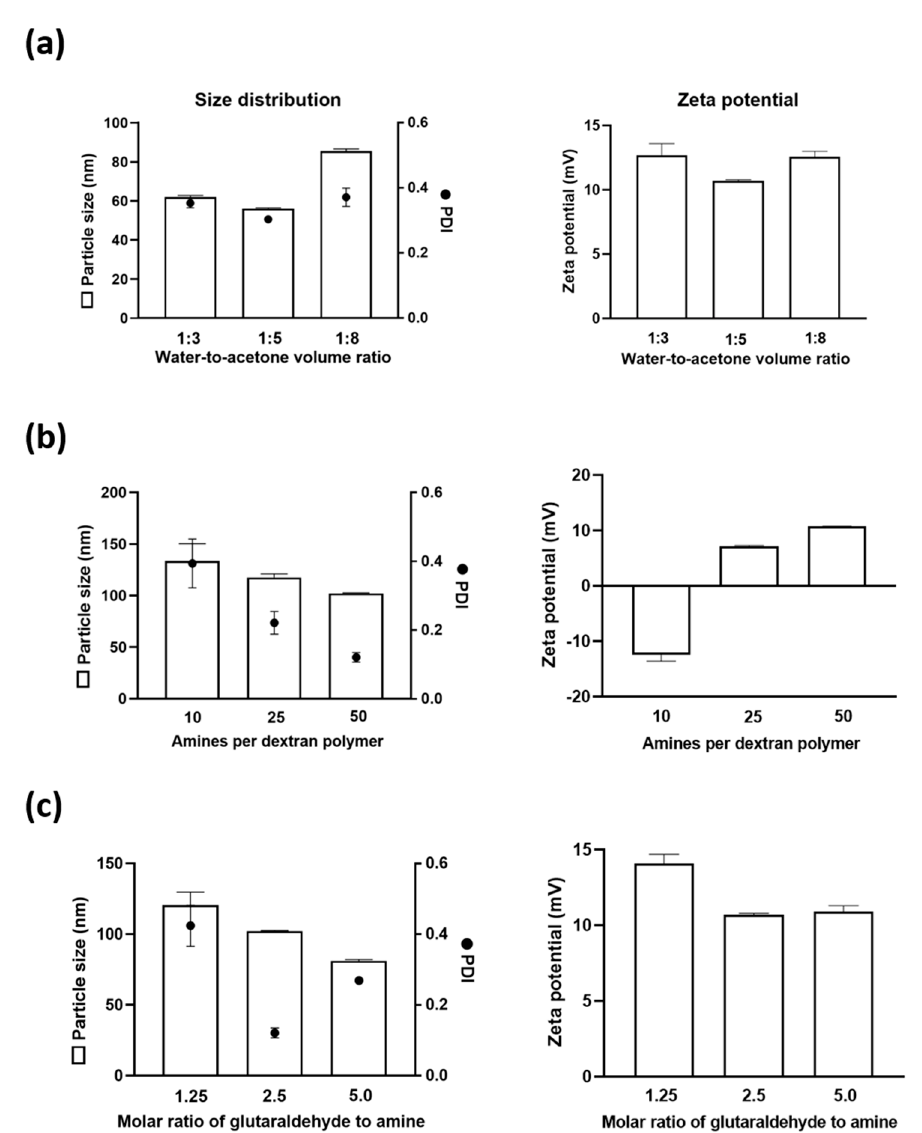
Figure 2. E ff ect of formulation parameters on the particle size, polydispersity index and surface charge of the amino-dextran nanoparticle. ( a ) E ff ect of water-to-antisolvent ratio: dextran with 50 amines per polymer; molar ratio of glutaraldehyde to amine (GAR) of 2.5. ( b ) E ff ect of amine functionality: water-to-antisolvent ratio of 1:5; GAR of 2.5. ( c ) E ff ect of glutaraldehyde content: dextran with 50 amines per polymer; water-to-nonsolvent ratio of 1:5. Data are presented as the mean ± S.D. ( n = 3).